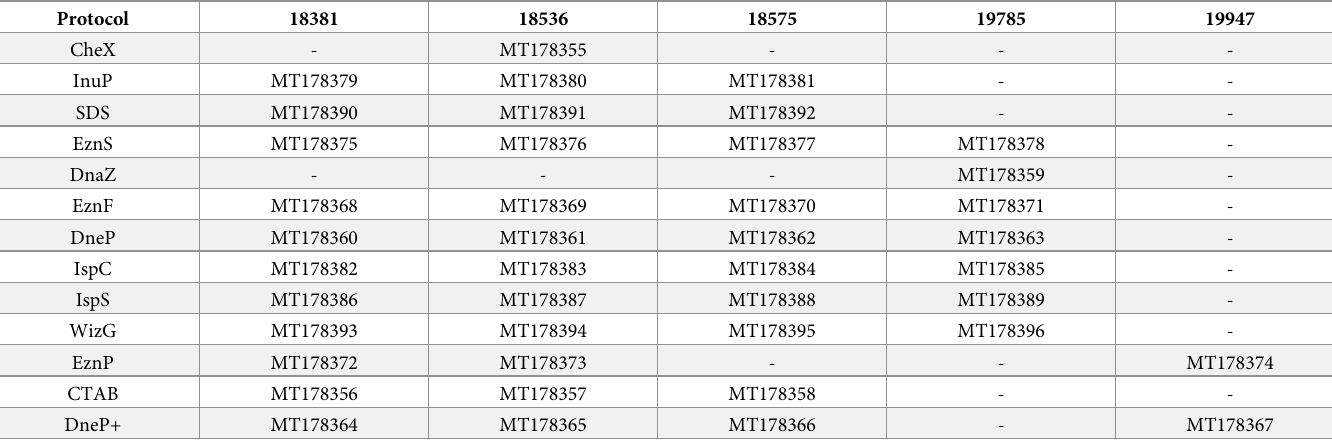
Table 8. Successful nested ITS PCR P . leucotricha amplicons GenBank accession numbers generated in this study.